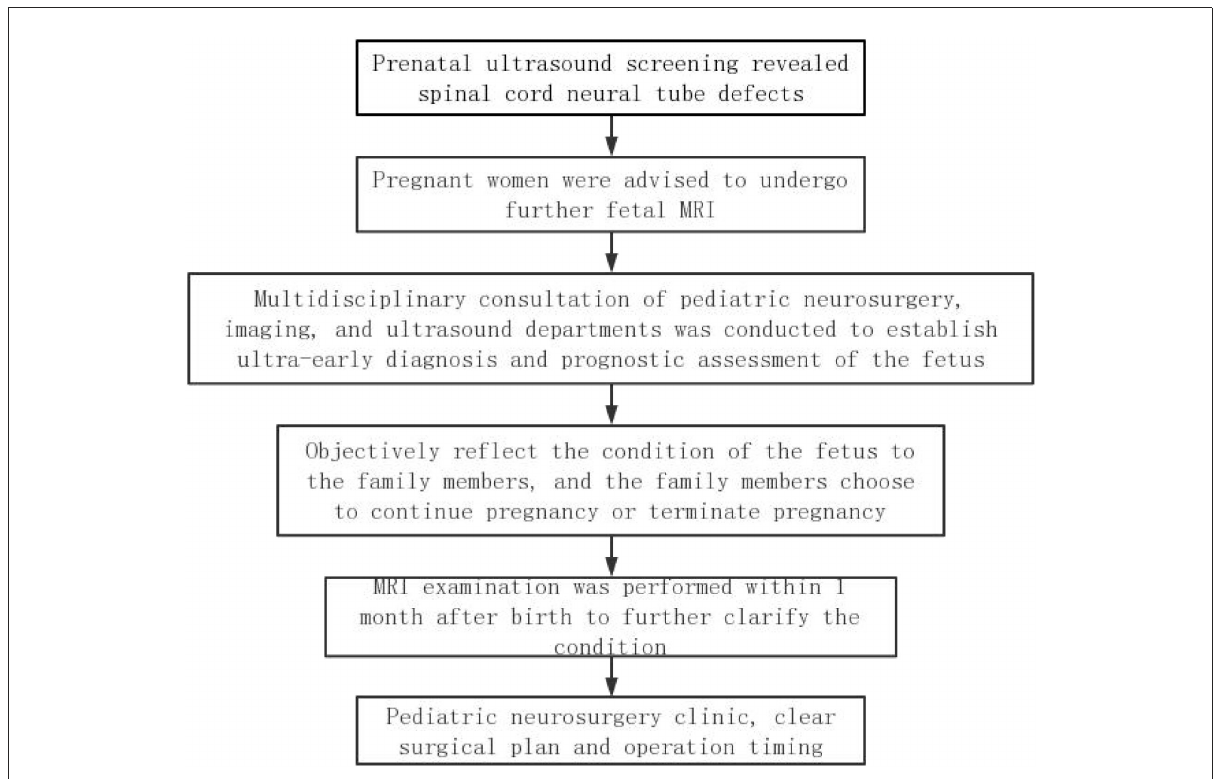
FIGURE4 The diagnosis and treatment procedures for spinal cord neural tube